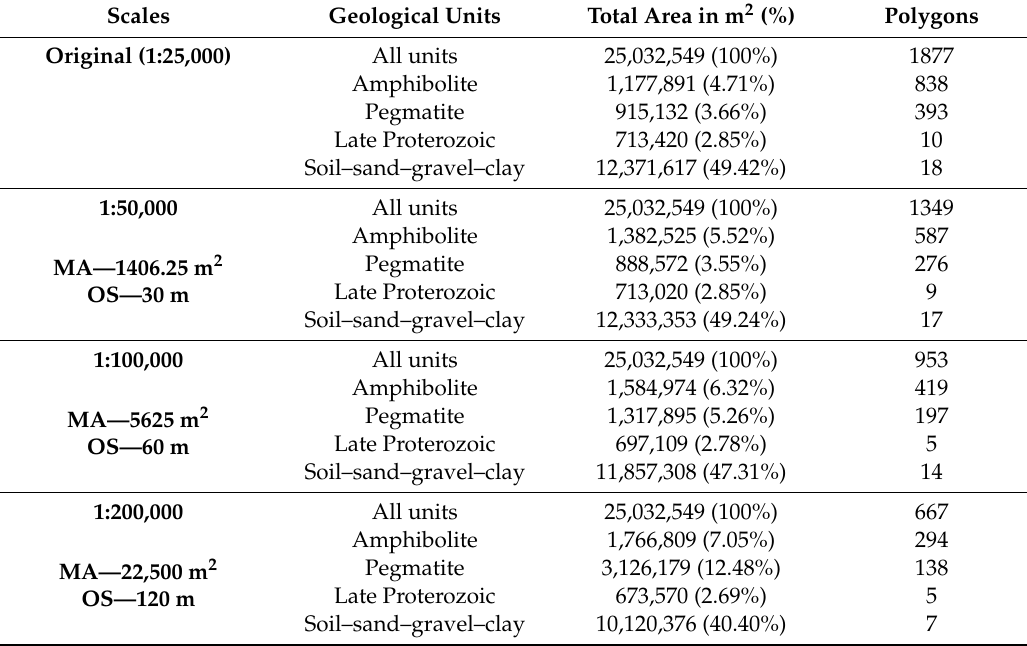
Table 5. E ff ect of scale reduction using the Compromise set of goal values for the MA and OS constraints (Table 4). The numbers are given for the map window of Figure 16.